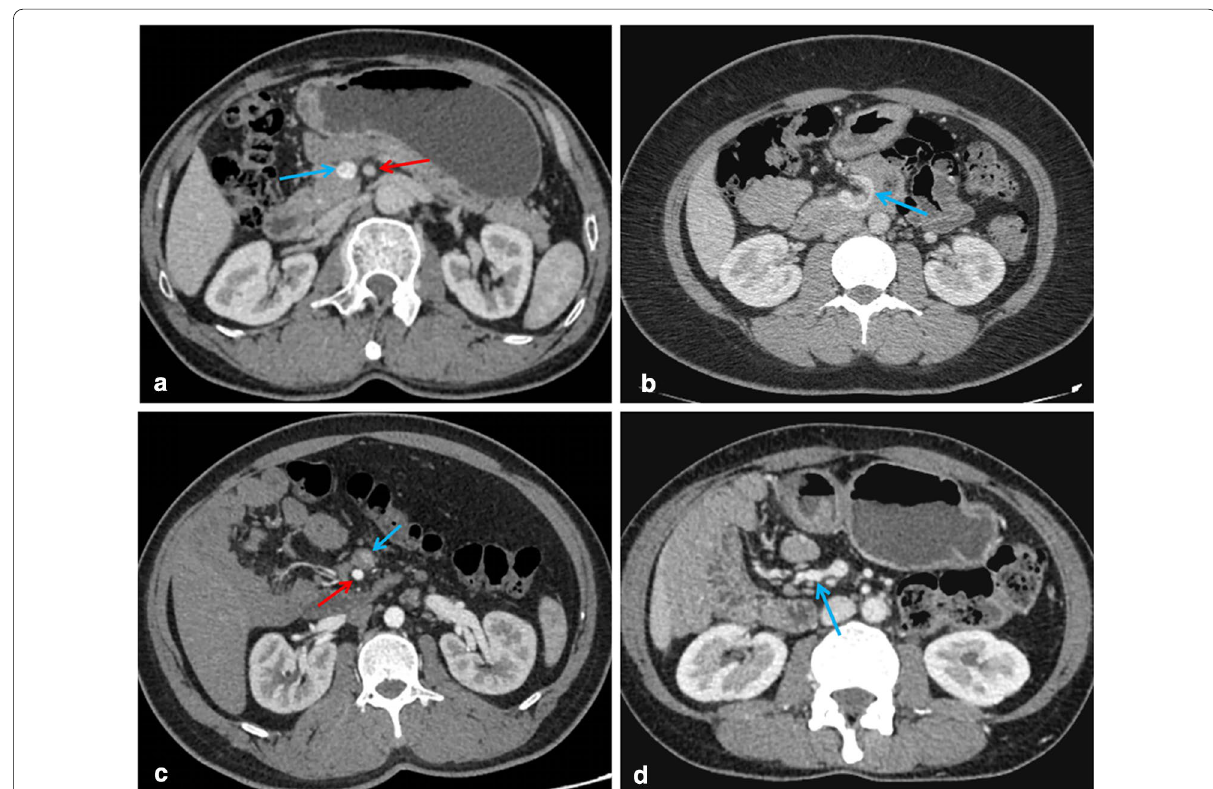
Fig. 3 Relationship between the superior mesenteric artery (red arrow) and superior mesenteric vein (blue arrow). a Normal (SMA on the left side of SMV); b the SMV forms an angle around the SMA toward the right abdominal cavity; c abnormal (inversion); 3d: the SMV goes straight to the right